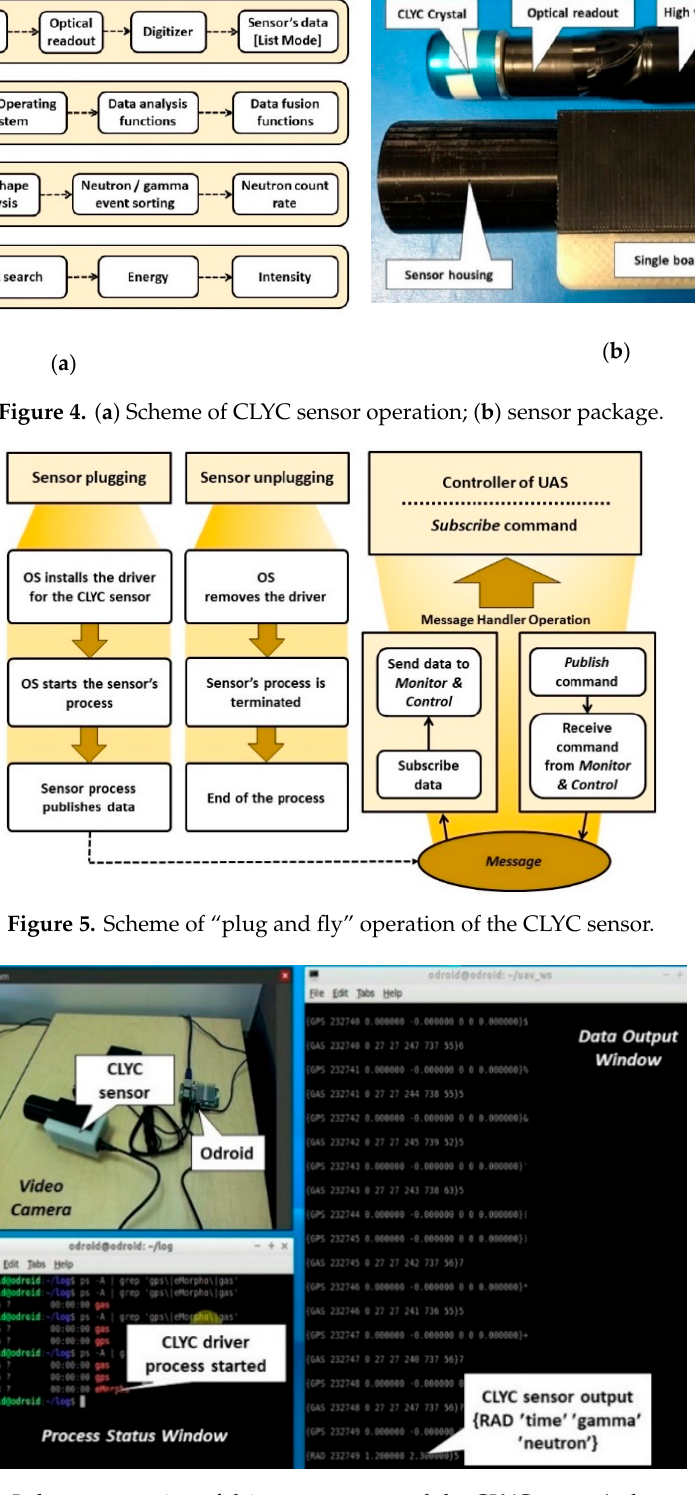
Figure 6. Laboratory testing of driver processes and the CLYC sensor’s data stream.